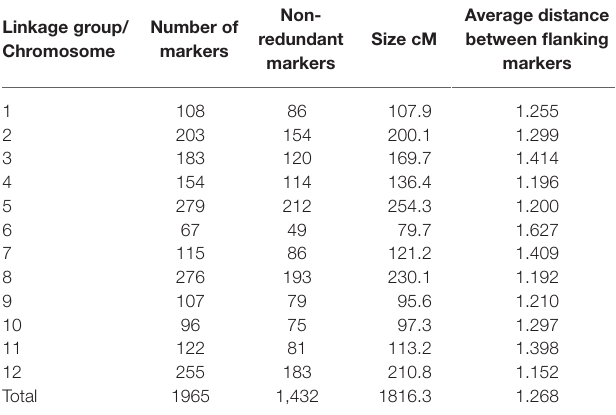
TABLE 2 | Genetic map information of Pop37